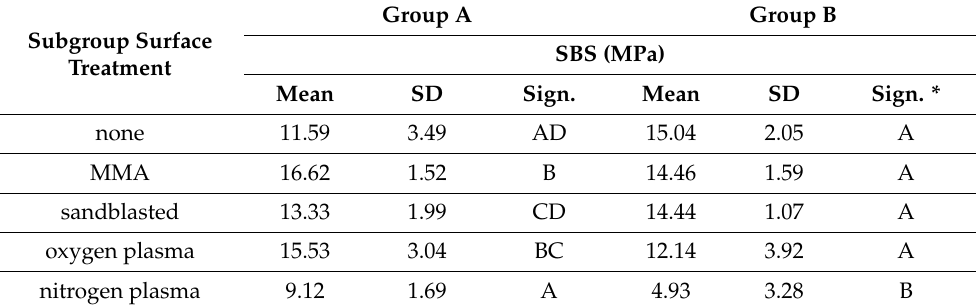
Table 2. Calculated bond strength in MPa as mean and standard deviation (SD) followed by pairwise comparison between the surface treatments within the groups (and statistical comparison between the two groups of materials (Groups A and B) for each surface treatment.